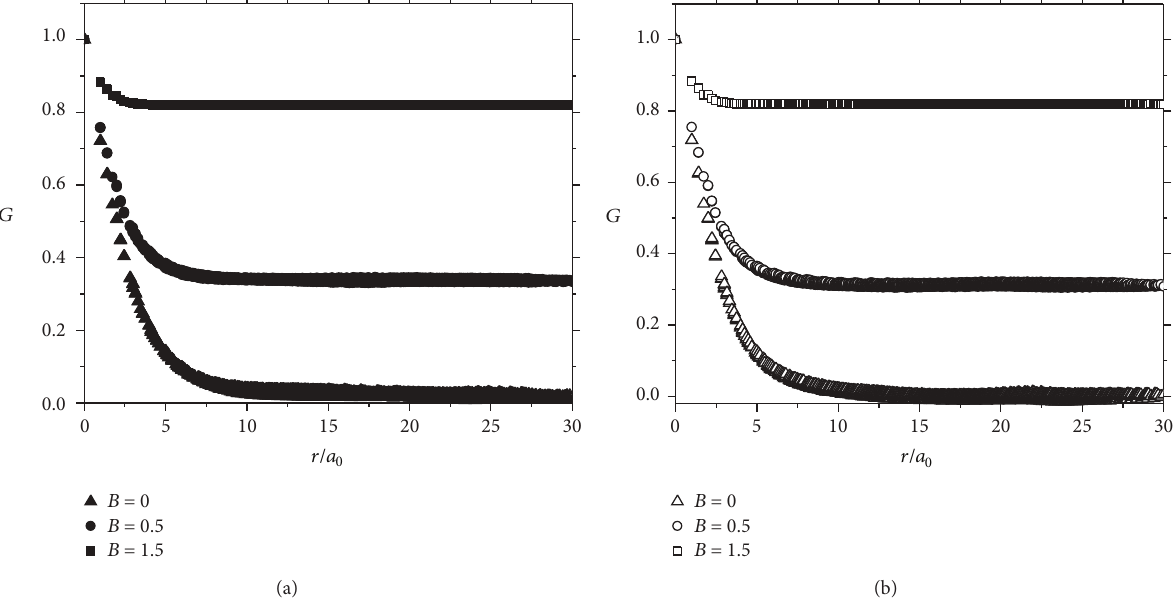
and 𝜉 ∼ 𝜉 𝑑 are external field dominated regime and disorder dominated regime , respectively. We estimate crossover values 𝐵 = 𝐵 𝑐 , which roughly separate both regimes, via intersection of linearized 𝜉(𝐵) dependencies obtained in limiting regimes 𝐵 ∼ 0 and 𝐵 ≫ 10 .